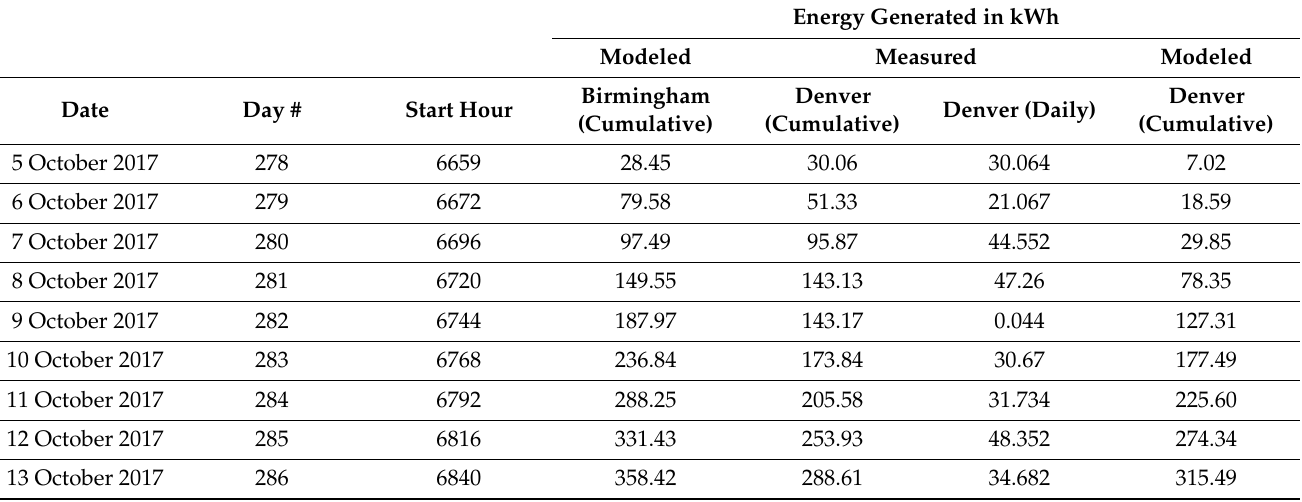
Table 11. Generated versus modeled PV electricity. Energy Generated in kWh Modeled Measured